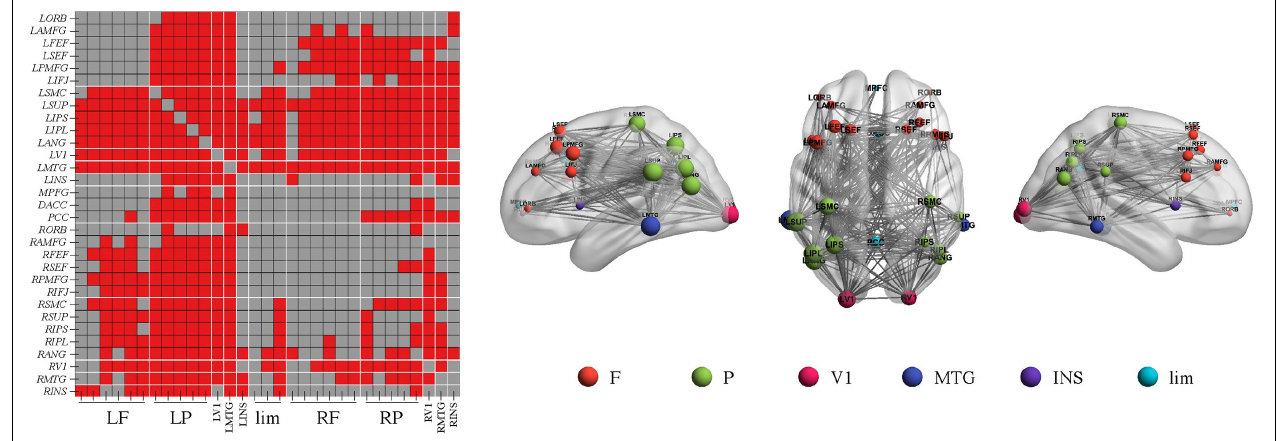
FIGURE 4 | Repetitive transcranial magnetic stimulation (rTMS) improves power envelope connectivity in the beta band in Alzheimer’s disease patients with moderate cognitive impairment. The network-based statistics results of post-rTMS > pre-rTMS in moderate group was shown. Connectivity difference matrix (left panel) and its three-dimensional visualization (right panel) are shown. The three-dimensional visualization shows the left, up, and right views of the brain. The meaning of the red squares, size of node, and all abbreviations are the same as in Figure 1